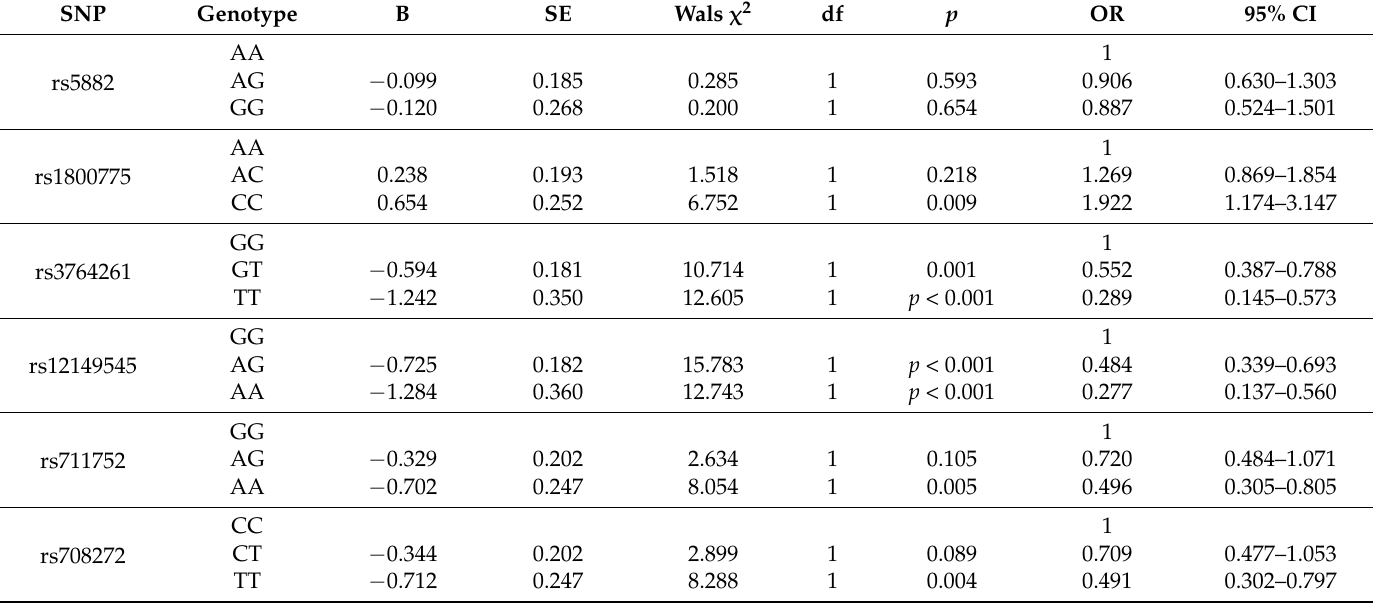
Table 4. The relationship between six CETP SNPs and metabolic syndrome